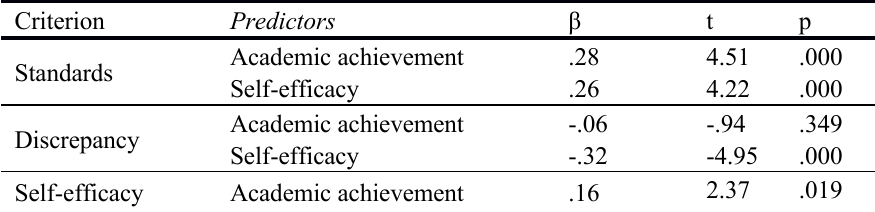
Table 5. Regressing standards and discrepancy on academic achievement and self- efficacy, and self-efficacy on academic achievement